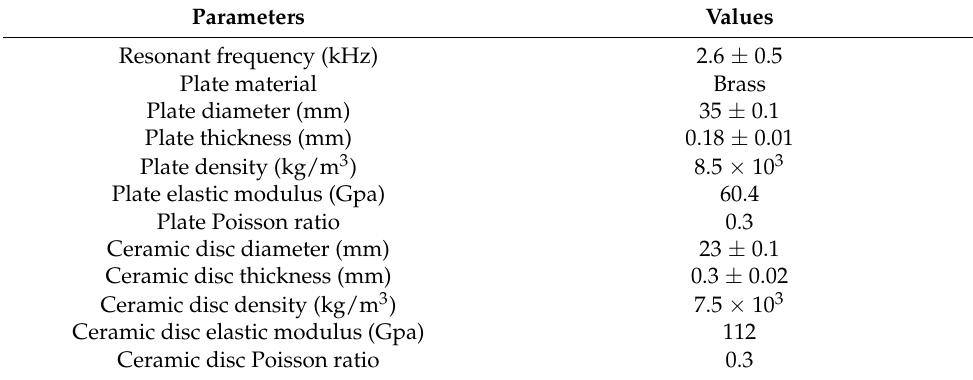
Table 2. Structural and material parameters of piezoelectric vibrator.